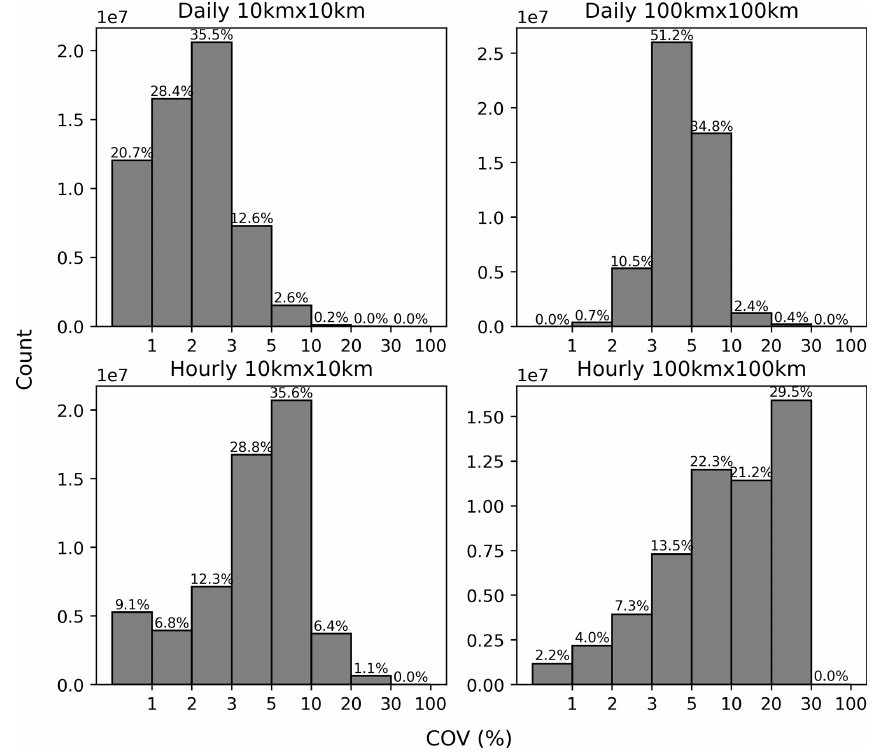
Figure 16. Histogram of the coefficient of variance (COV) for daily and hourly scales at 10km × 10km and 100km × 100km resolutions over the study area. The number above each bar indicates the relative